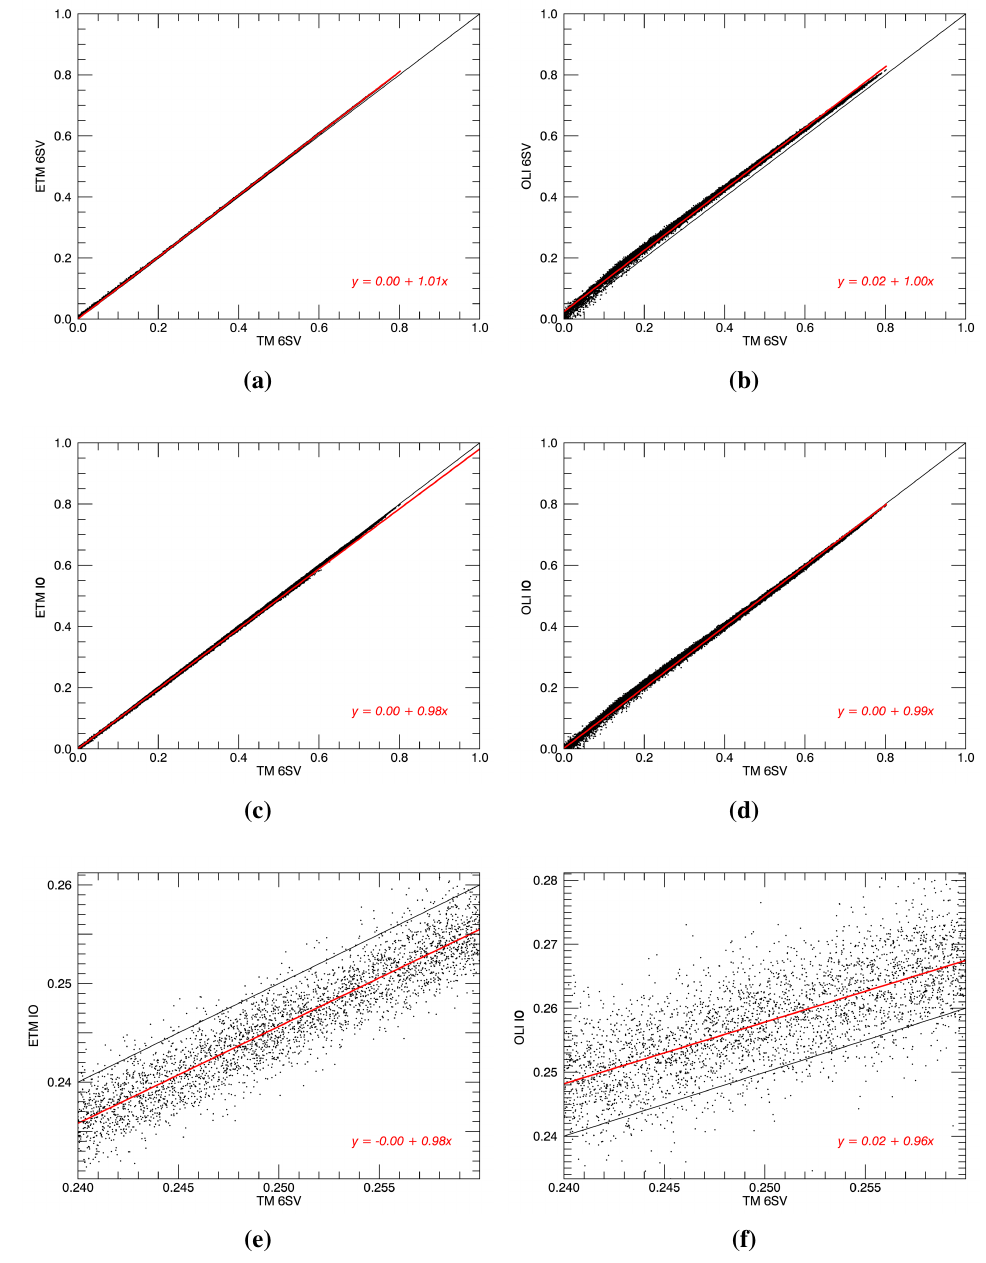
Figure 5. NDVI scatter plots to compare the sensors of the Landsat series, based on simulations through one Hyperion image. ( a ), ( b ) comparison between NDVI values (TM vs. ETM and OLI respectively) computed from reflectances derived by 6SV model and convolved; ( c ), ( d ) NDVI values from TM image corrected by 6SV (assumed as reference) vs. values from simulated ETM and OLI images respectively, corrected by invariant object (IO) method; ( e ), ( f ) the same as ( c ), ( d ) but for a narrower wavelength interval (0.24–0.26 microns). Regression lines are plotted in red colour, identity lines in